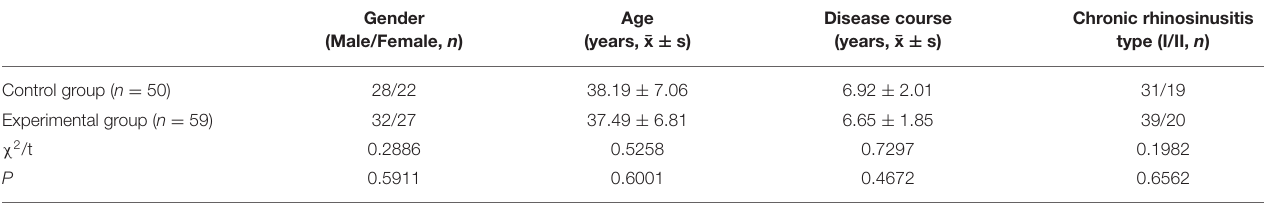
TABLE 1 | Comparison of baseline information of patients between the two groups.